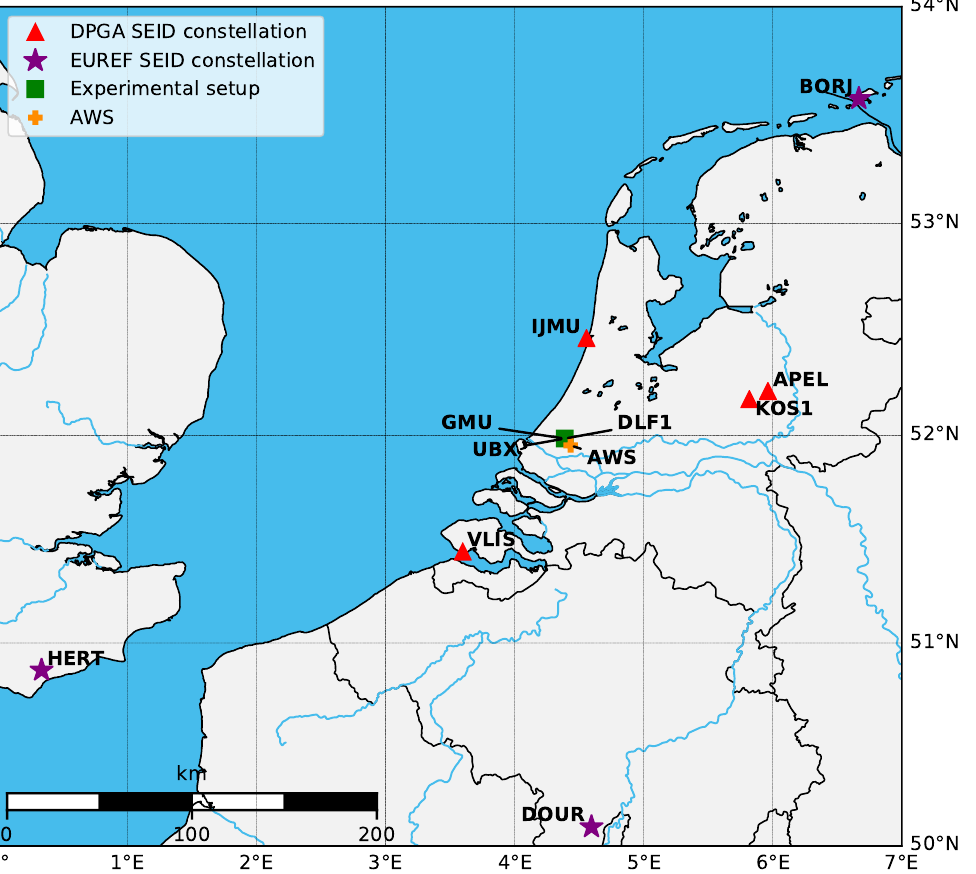
Figure 1. Positions of the SEID reference stations of the DPGA (red triangles) and EUREF (purple stars) constellations, the experimental setup in Delft (green square), and the AWS (orange cross). The sites DLF1, Geo Monitoring Unit (GMU), and u-blox NEO-M8T evaluation toolkit (UBX) are all co-located within a 10 m 2